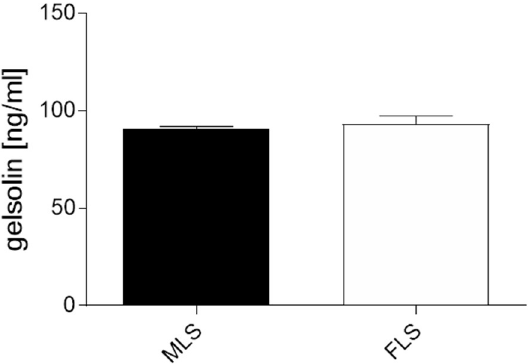
Figure 4. ELISA analysis of MLS and FLS. Isolated and cultured MLS and FLS isolated out of the synovial membrane of osteoarthritis patients produce GSN at approximately the same concentration (0.09 µg/mL). ELISA analysis of gelsolin in MLS and FLS, t -test.